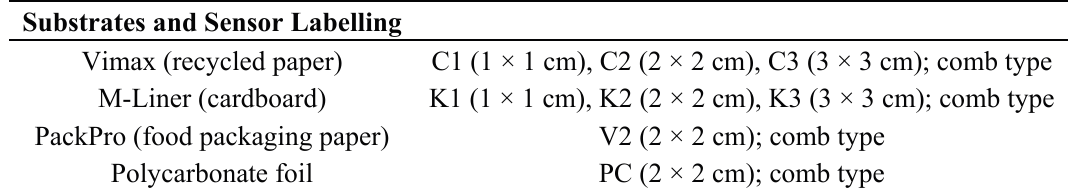
Table 1. Printing substrates and sensor labelling.